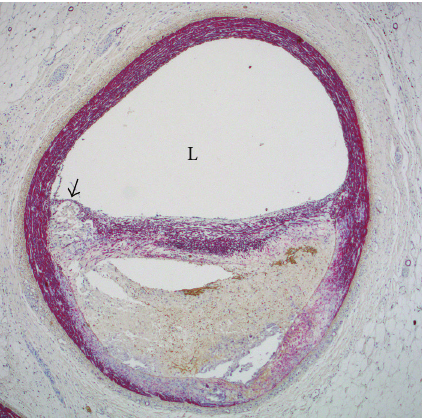
Figure 2: Photomicrograph of a lesion from an eccentric 13-month-old Rapacz-FH minipig coronary artery. Arrow denotes a thin fibrous cap covering a foam cell rich area with necrotic cores (empty areas within the lesion). The pig was fed a mixed high/fat, low/fat diet. Photomicrograph kindly provided by Dr. Erling